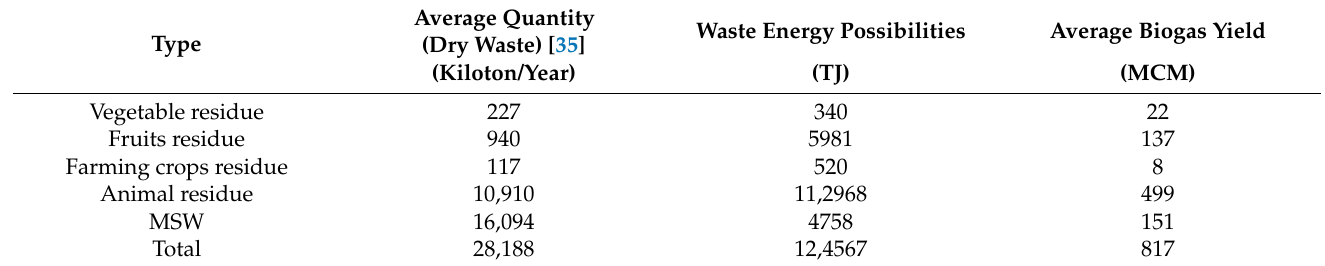
Table 7. Biomass residues in Jordan between 2014 and 2019 (available data).